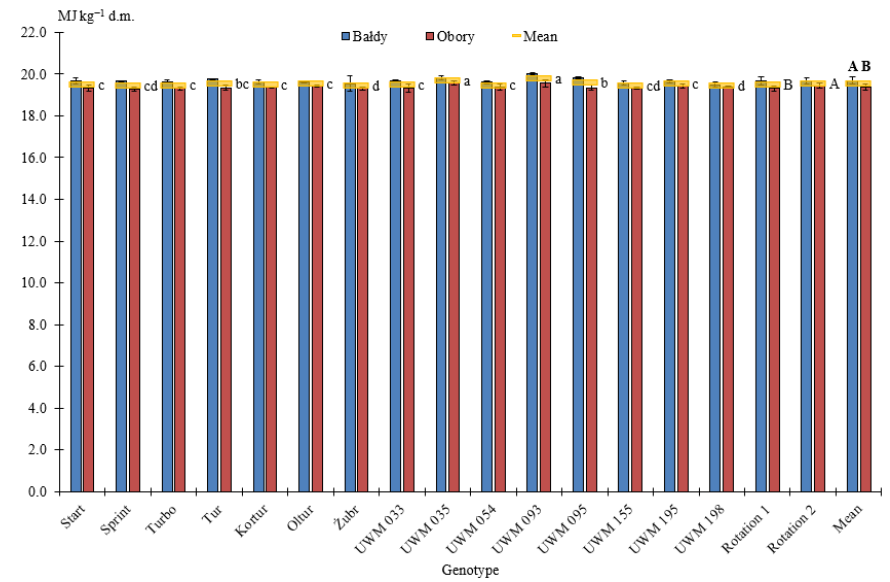
Figure 4. Volatile matter content in the biomass of 15 willow genotypes obtained at two locations in two consecutive three-year harvest rotations; (legend see Figure 1).